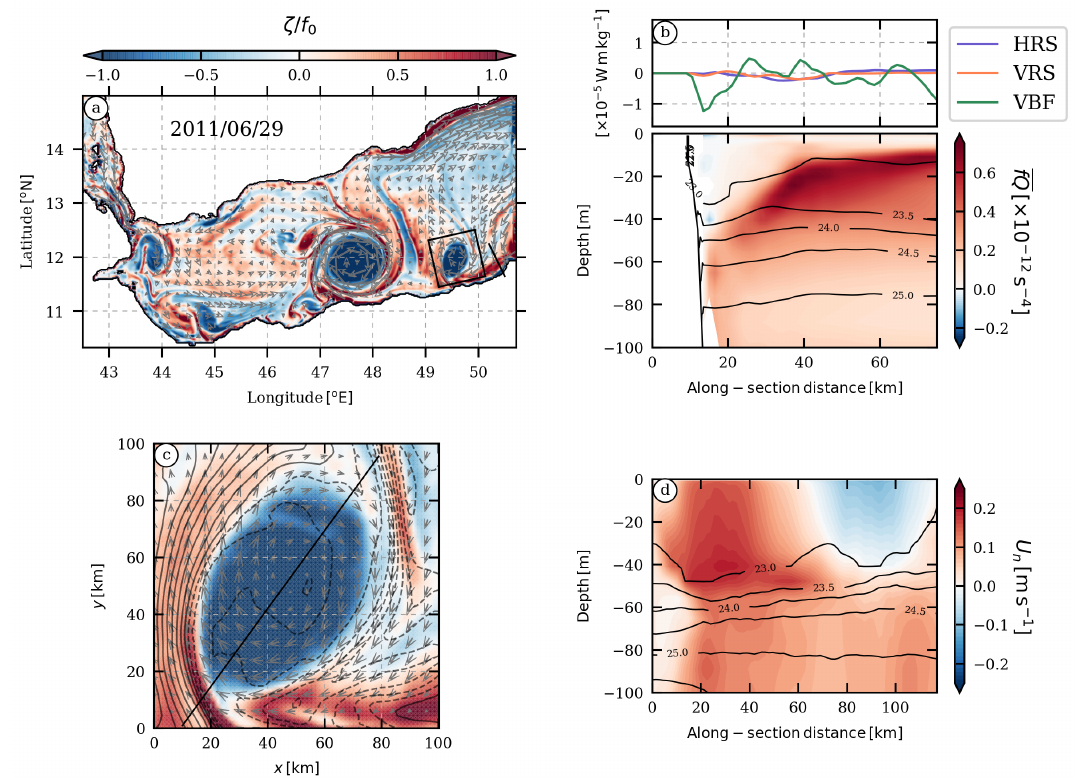
Figure 7. ( a ) Instantaneous surface vertical relative vorticity normalized by the areal average of the Coriolis frequency ( f 0 ) in the Gulf of Aden. ( b , top ) Energy conversion terms integrated from the surface down to 100 m depth, and timely averaged over the 10 days before the date indicated in ( a ): horizontal Reynolds stress (HRS, in blue), vertical Reynolds stress (VRS, in orange), and vertical buoyancy flux (VBF, in green) in the along-section direction (see solid black line in ( a ) for location). ( b , bottom ) Vertical slice of the potential vorticity ( Q ) multiplied by the Coriolis frequency ( f ) (see solid black line in ( a ) for location) timely averaged over the 10 days before the date indicated in ( a ). Density contours are represented as solid black lines. ( c ) Zoom in the Gulf of Aden (see black squared box in ( a ) for location) over a submesoscale anticyclone near the southern coast. ( d ) Vertical slice of the normal velocity (see solid black line in ( c ) for location). Density contours are represented as solid black